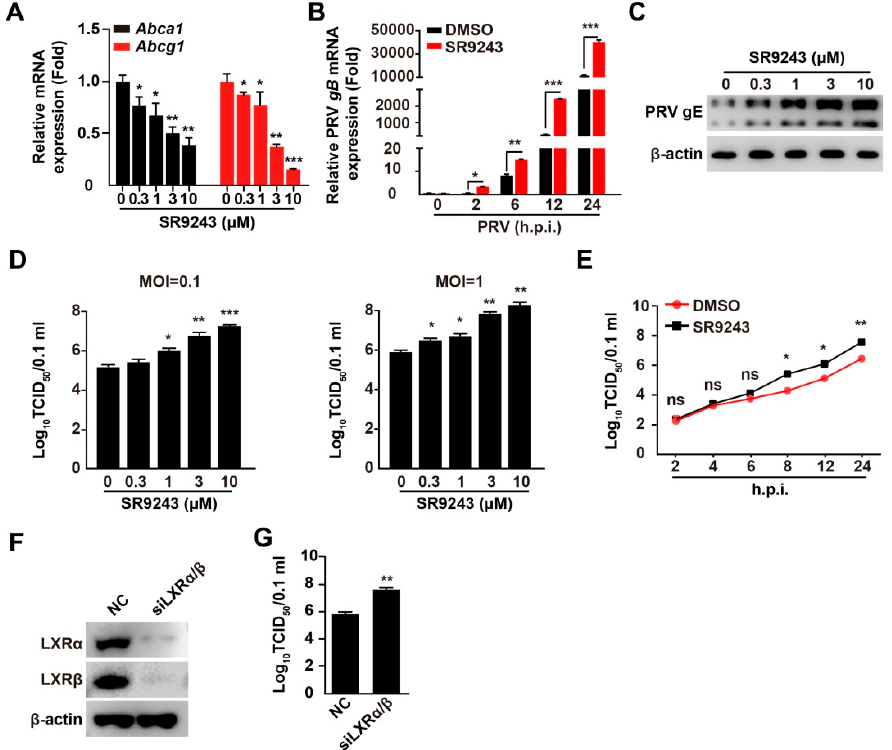
Figure 2. LXR inverse agonist SR9243 promotes PRV proliferation. ( A ) PK-15 cells were treated with SR9243 (0–10 μ M) for 24 h. Abca1 and Abcg1 mRNA was assessed by qRT-PCR analysis. * p < 0.05, ** p < 0.01, *** p < 0.001. ( B ) PK-15 cells were infected with PRV-QXX (MOI = 0.1) and simultaneously treated with DMSO or SR9243 (10 μ M) for 0–24 h. PRV gB mRNA was assessed by qRT-PCR analysis. * p < 0.05, ** p < 0.01, *** p < 0.001. ( C ) PK-15 cells were infected with PRV-QXX (MOI = 0.1) and simultaneously treated with SR9243 (0–10 μ M) for 24 h. PRV gE was assessed by immunoblotting analysis. ( D ) PK-15 cells were infected with PRV-QXX (MOI = 0.1 and 1) and simultaneously treated with SR9243 (0–10 μ M) for 24 h. Viral titers were assessed by a TCID 50 assay. * p < 0.05, ** p < 0.01, *** p < 0.001. ( E ) PK-15 cells were infected with PRV-QXX (MOI = 0.1) and simultaneously treated with SR9243 (10 μ M) for 2–24 h. One-step growth curves of PRV-QXX were assessed using a TCID 50 assay of viral titers. * p < 0.05, ** p < 0.01. ns, no significance. ( F ) PK-15 cells were transfected with NC and siLXR α / β for 48 h. LXR α and LXR β were assessed by immunoblotting analysis. ( G ) PK-15 cells were transfected with NC and siLXR α / β . At 24 h post-transfection, cells were infected with PRV-QXX (MOI = 1) for another 24 h. Viral titers were assessed by a TCID 50 assay. ** p < 0.01.